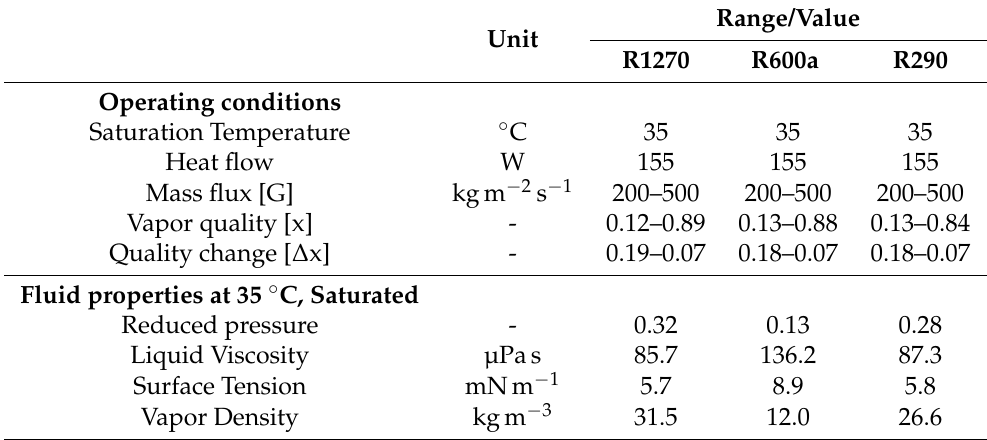
Table 2. Operating conditions for experimental